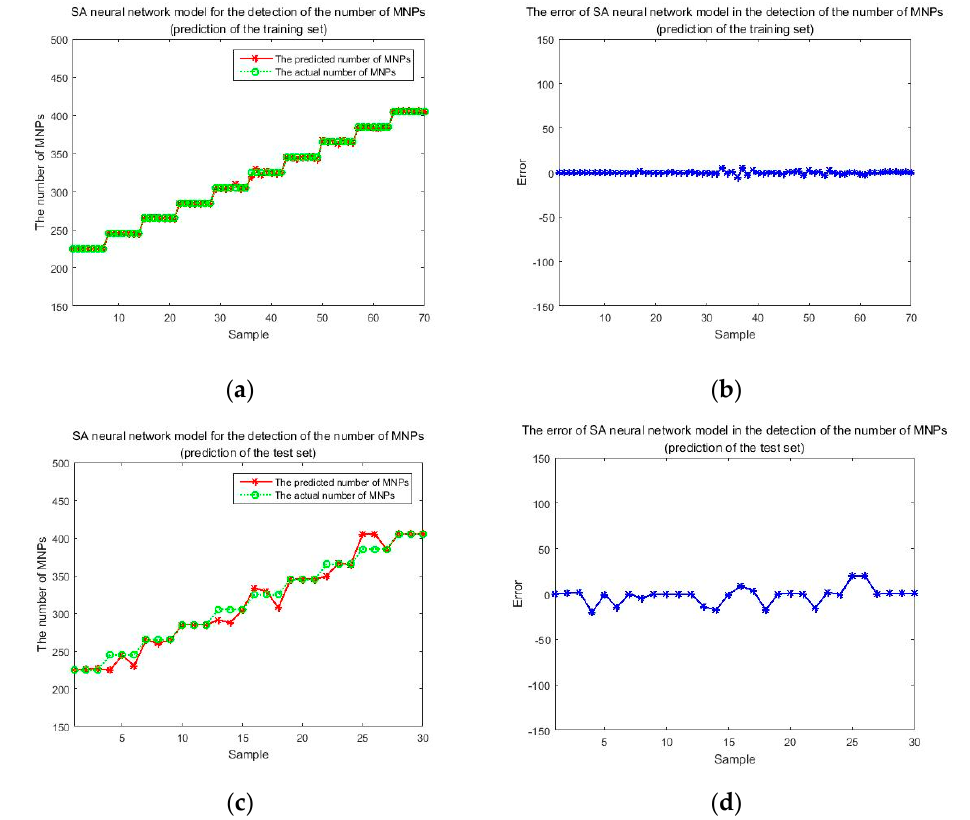
Figure 17. MNPs number detection model based on SA neural network: ( a ) the prediction results of SA neural network model for the training set, ( b ) the prediction error of SA neural network model for the training set, ( c ) the prediction results of SA neural network model for the test set, and ( d ) the prediction error of SA neural network model for the test set.